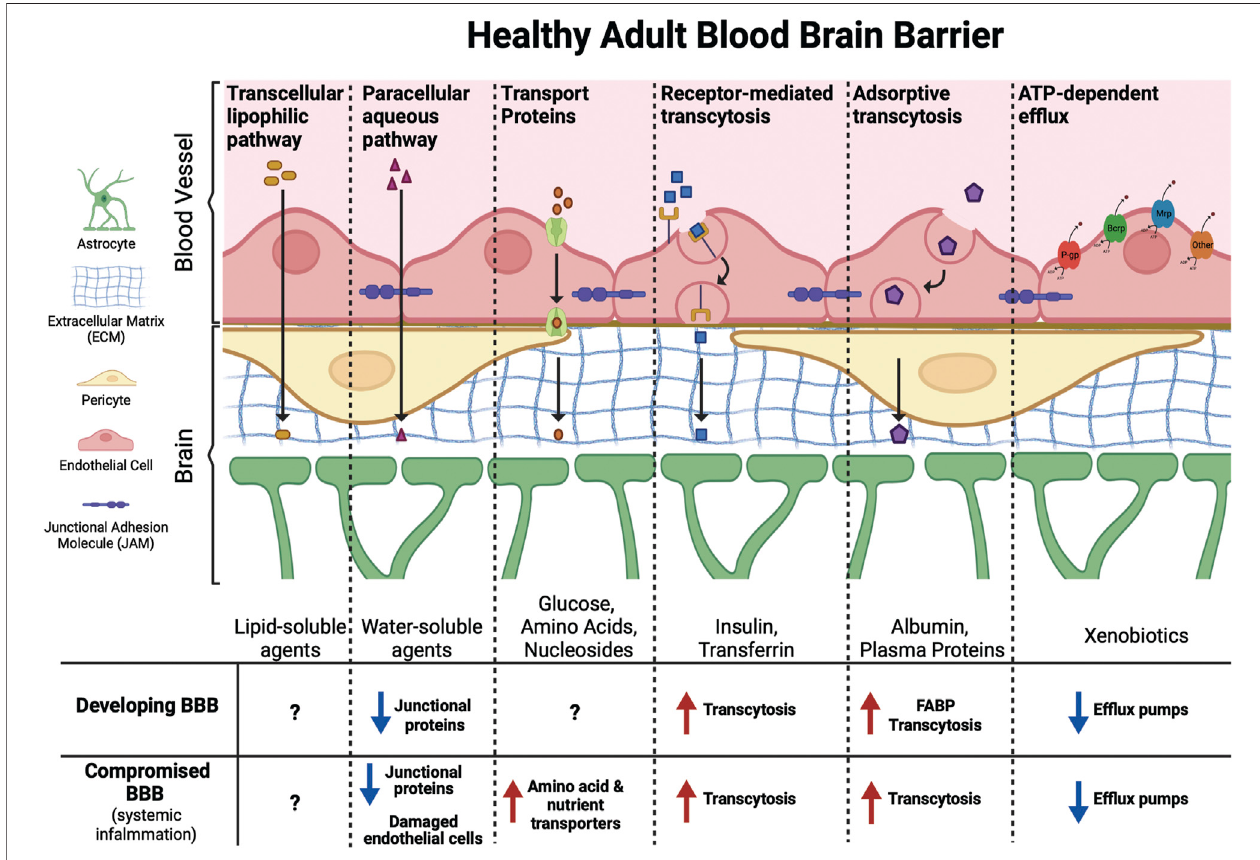
FIGURE 2 | Molecules of different sizes and biochemical properties can gain access to the brain via diverse mechanisms. This includes facilitated (transport proteins, receptor-mediated transcytosis, and adsorptive transcytosis) and passive (transcellular lipophilic and paracellular aqueous pathways) transport across the BBB.ATP-dependentef fl uxtransportersprotectthebrainfromtoxicxenobioticsandendogenousmetabolites.Thesetransportersincludep-glycoprotein(P-gp),breast cancer resistance protein (Brcp), and multidrug resistance-associated protein (Mrp) among others. The developing BBB has not yet reached its full functional capacity, with fewer junctional proteins, increased transcytosis, and lower expression of ef fl ux pumps compared to the adult BBB may leave the fetal and infant brain more vulnerable to PFAS exposure. Similarly, certain ailments, such as conditions that cause systemic in fl ammation, can compromise the BBB leading to increased transport of xenobiotics into the